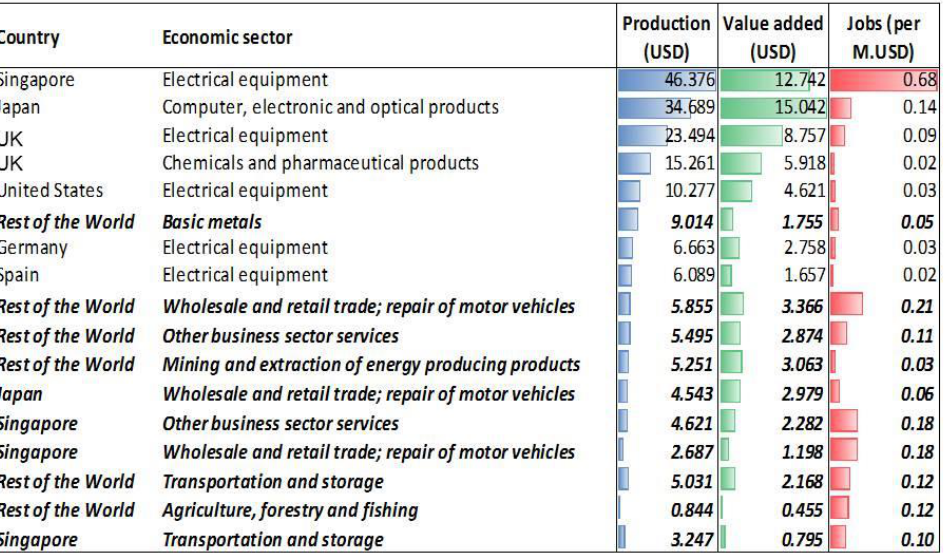
Figure 6. The main economic sectors responsible for the largest shares of socioeconomic